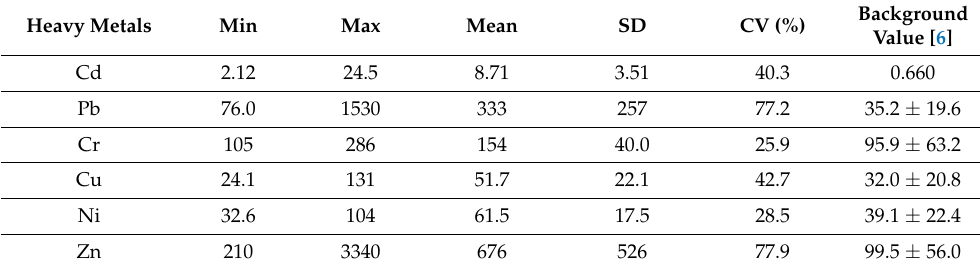
Table 2. Summary statistics of heavy metals of agricultural soils in study area (mg · kg − 1 ) (n =